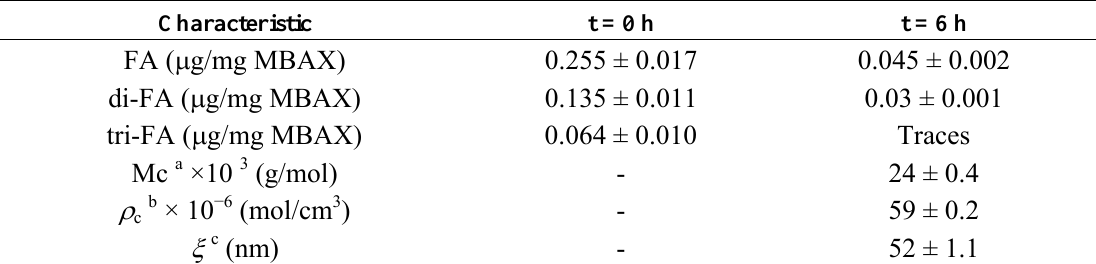
Table 1. Characteristics of MBAX before and after 6 h of cross-linking process. Characteristic